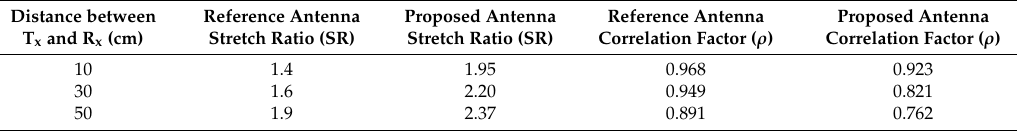
Table 4. Pulse width stretch ratio and correlation coefficient for the antenna at various distances. Distance between Reference Antenna T x and R x (cm) Stretch Ratio